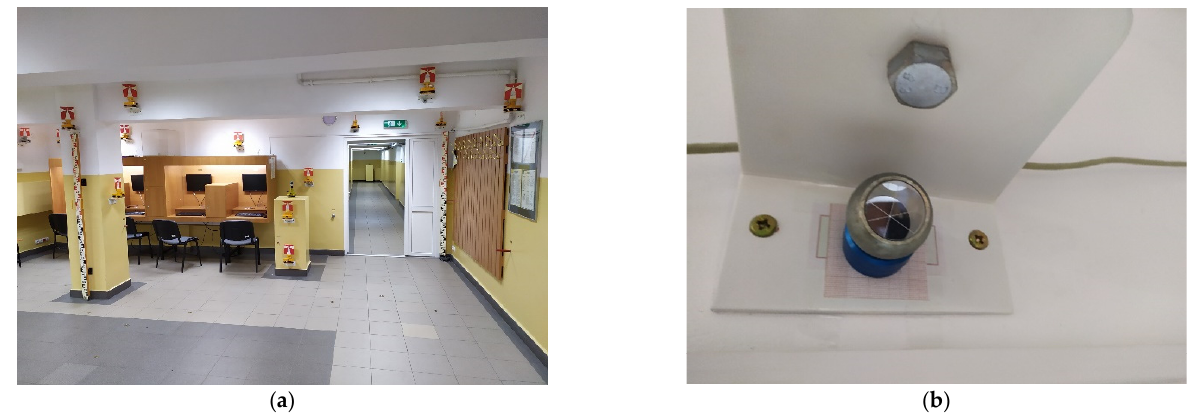
Figure 10. Surveying laboratory view from the instrument’s perspective; marked control points deployed ( a ), and the precise ball prism ( b ) used for targeting the instrument telescope.